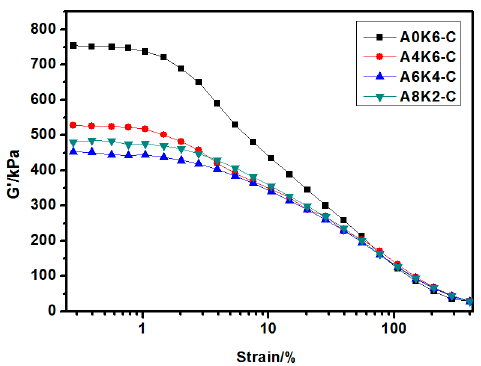
(cid:48) ) of four silica/NR